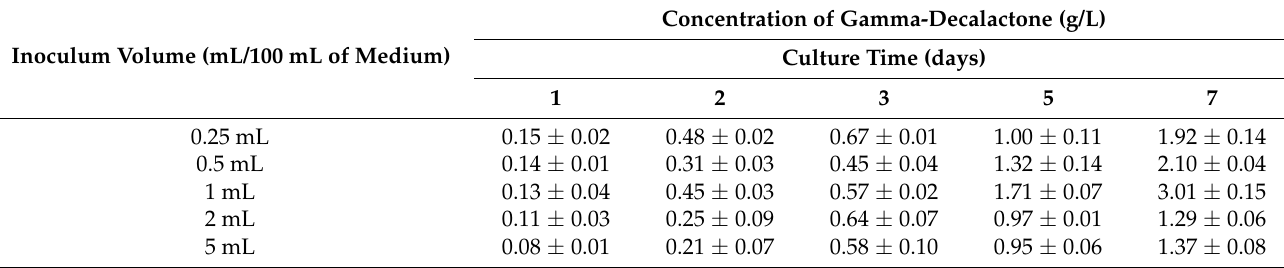
Table 2. Effect of inoculum size on the concentration of gamma-decalactone in the medium during the 7-day culture. Concentration of Gamma-Decalactone Inoculum Volume (mL/100 mL of Medium)